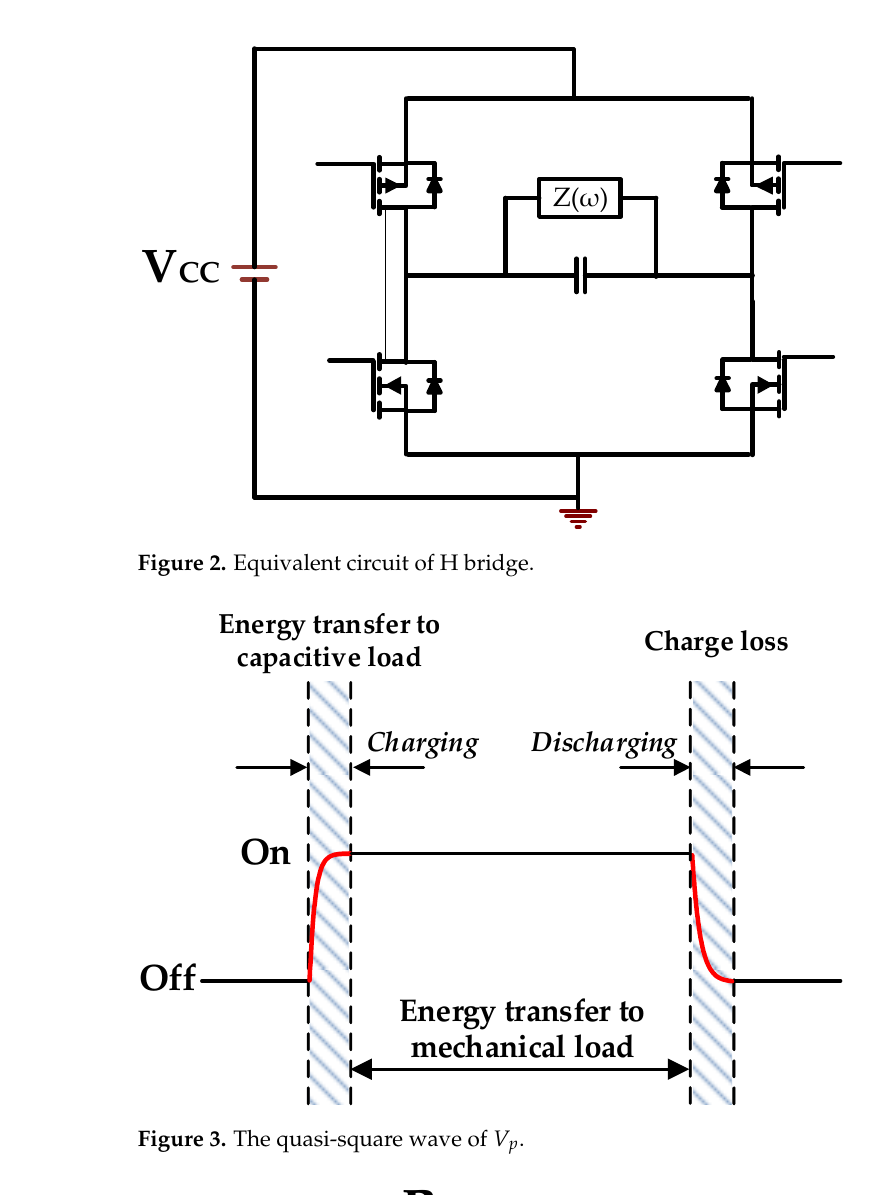
Figure 3. The quasi-square wave of V